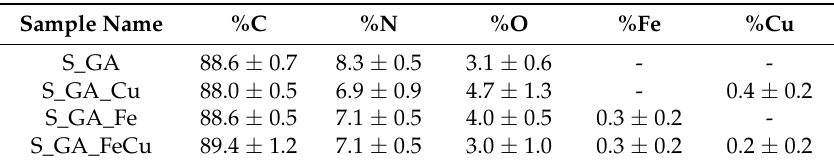
Table 2. Samples’ Surface Atomic Composition